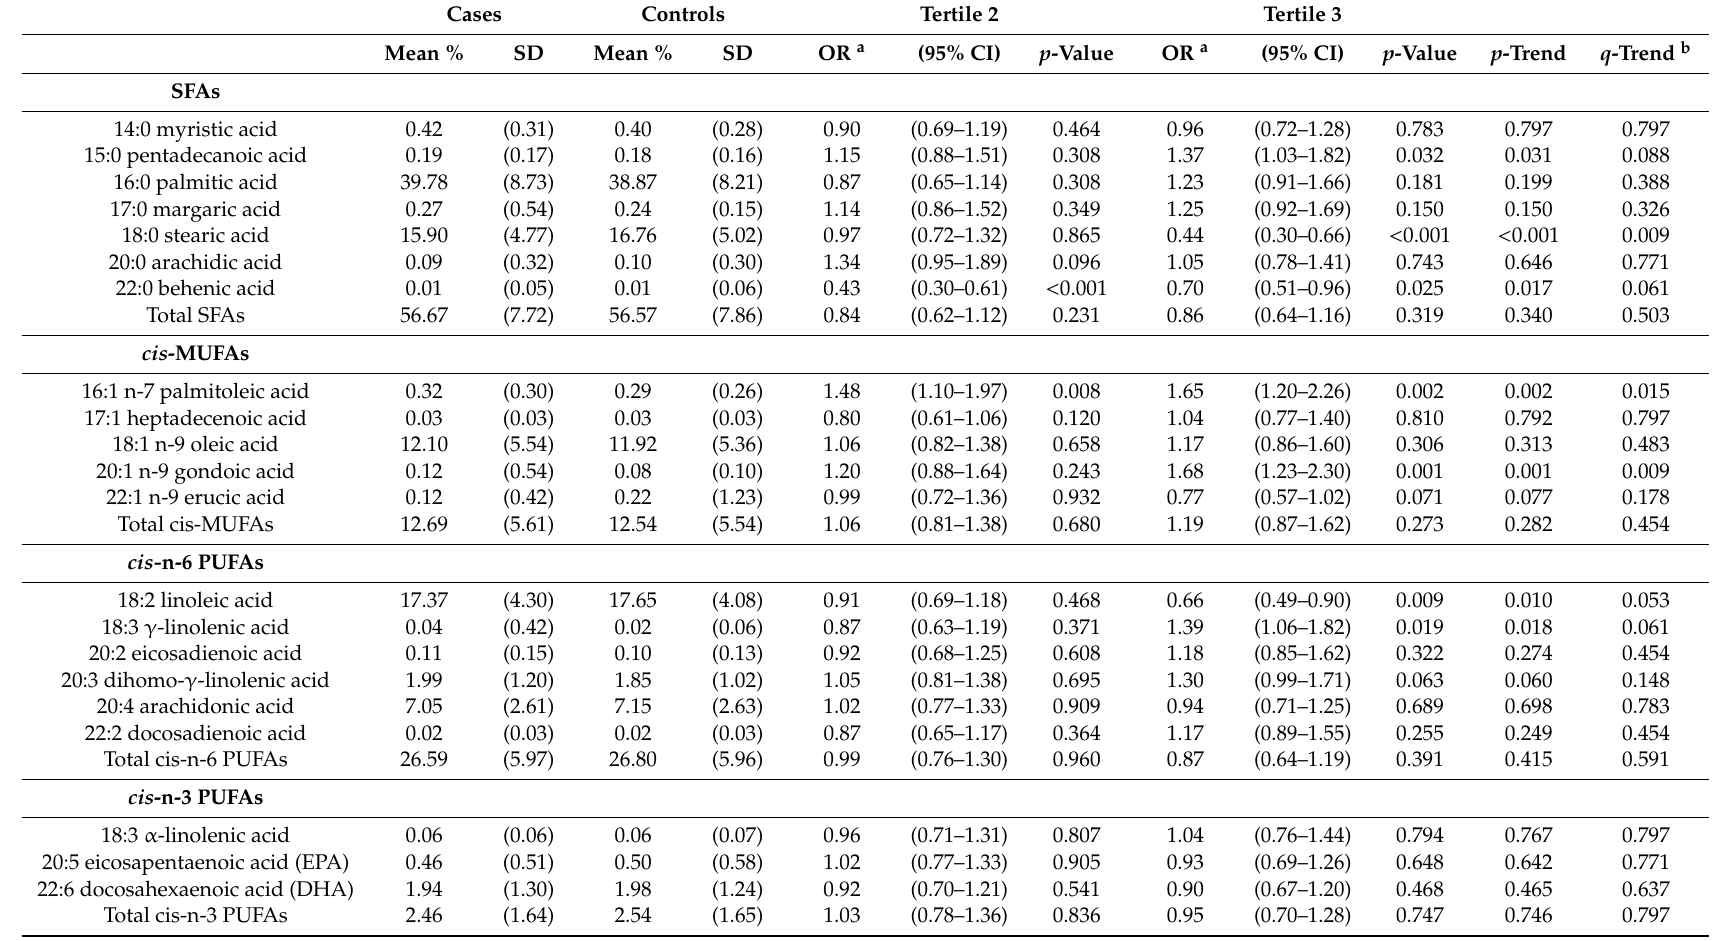
Table 2. Breast cancer risk by tertiles of serum phospholipid fatty